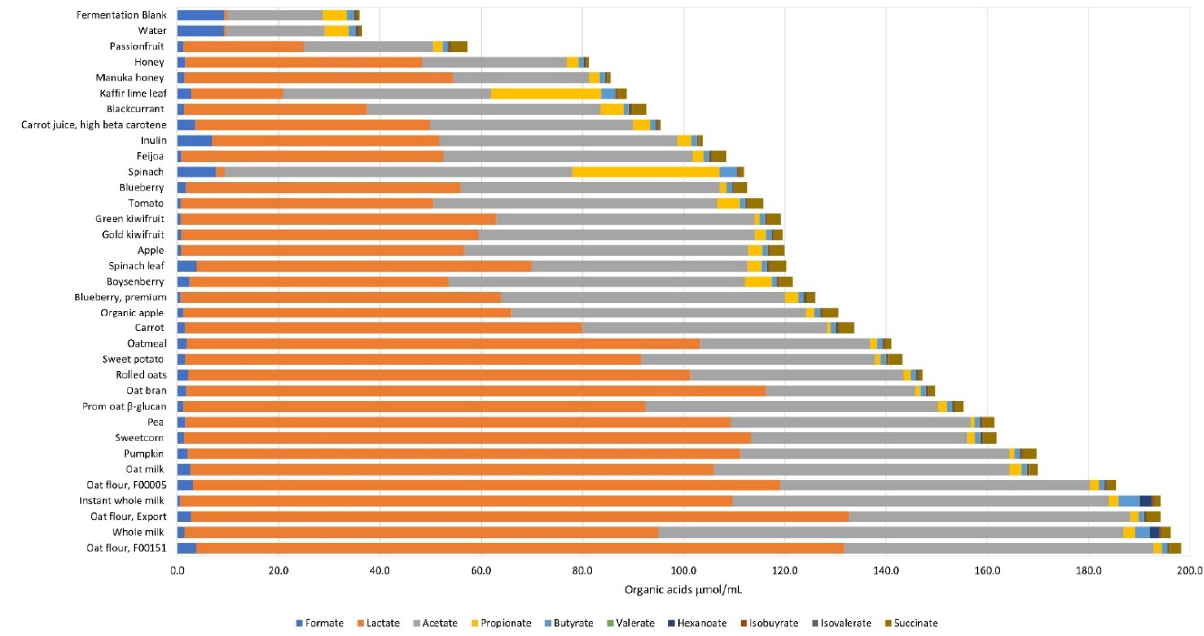
Figure 2. Average organic acid profiles of the 32 food ingredients, inulin (positive control), water, and the fermentation blank at 10 h fermentation with the pooled infant fecal slurry ( n = 3). The statistical differences are given in Supplementary Tables S2 and